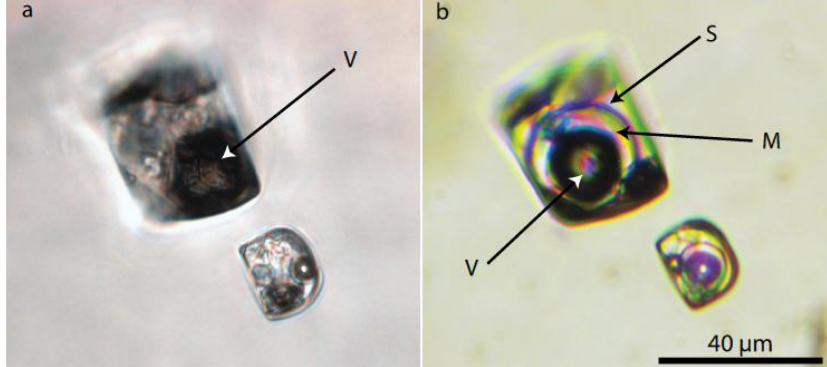
Figure 11. Two boron-rich fluid or melt inclusions of type-C in quartz from the Mokhovaya pegmatite ( a ) before heating and ( b ) after heating to 310°C using a microscope heating stage. during heating to the homogenization temperature (t boric acid melted incongruently at about 169°C into metaboric acid HBO B O melt, which attached to the vapor bubble on cooling. Note, at the homogenization 2 3 temperature, small suspended particles in the homogeneous fluid show a rapid movement inside of the inclusion, demonstrating the water-like extremely low